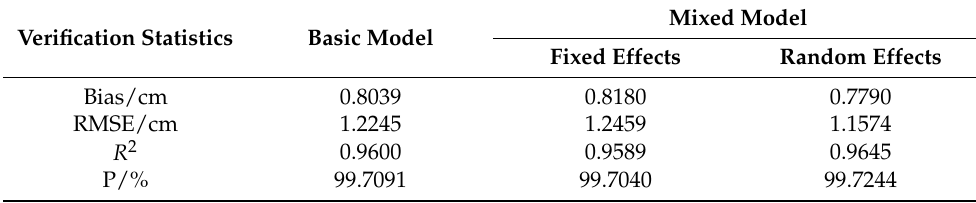
Table 11. Validation for the basic and mixed